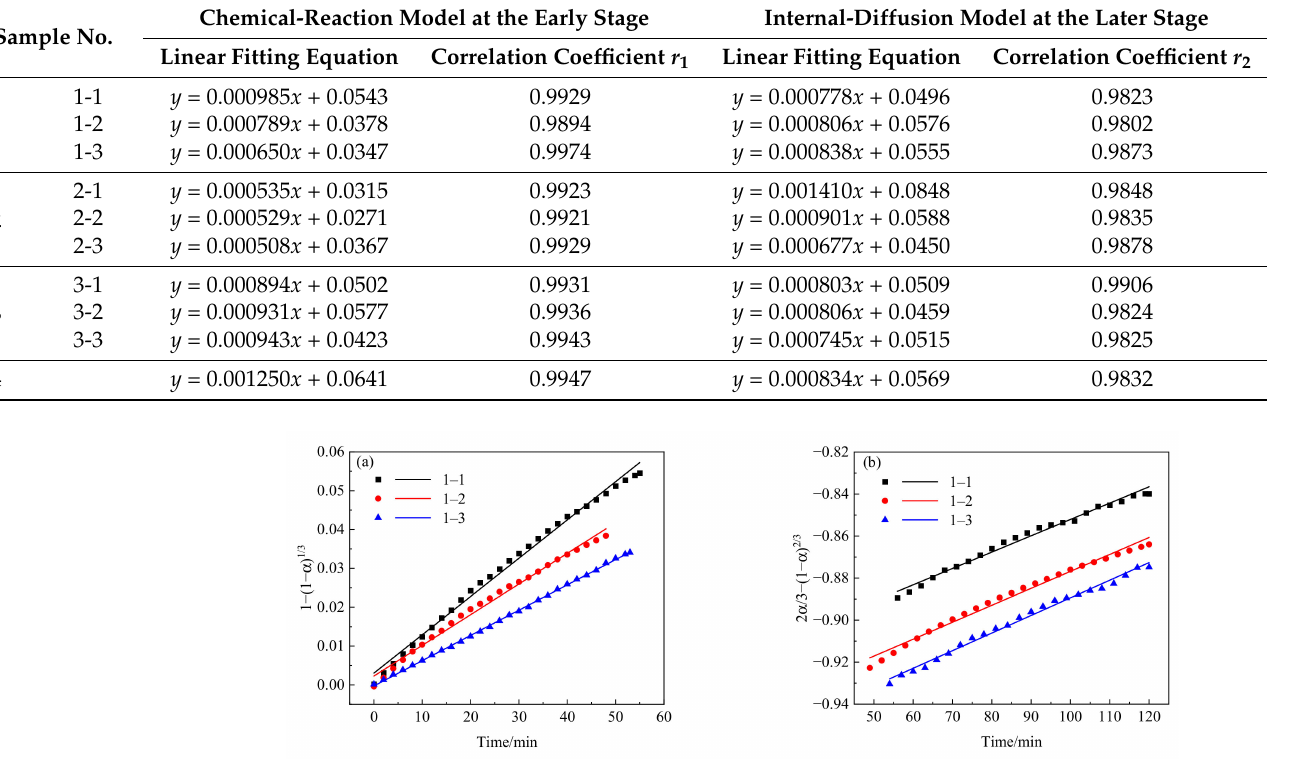
Table 4. Linear fitting equation and correlation coefficients at different stages.